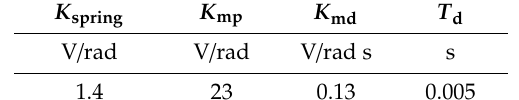
Figure 12. Frequency response of cam angle control at 500 kPaG.